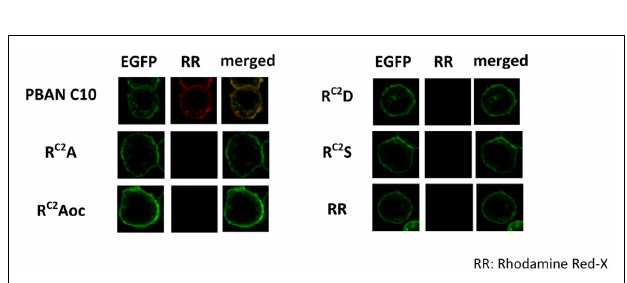
FIGURE 3 | Confocal imaging of BomPBANR – EGFP expressing Sf9 cells after incubation with synthetic peptides labeled with Rhodamine Red-X. Each fluorescence labeled peptide was added at a final concentration of 100nM. Co-localization is indicated by yellow in the merged